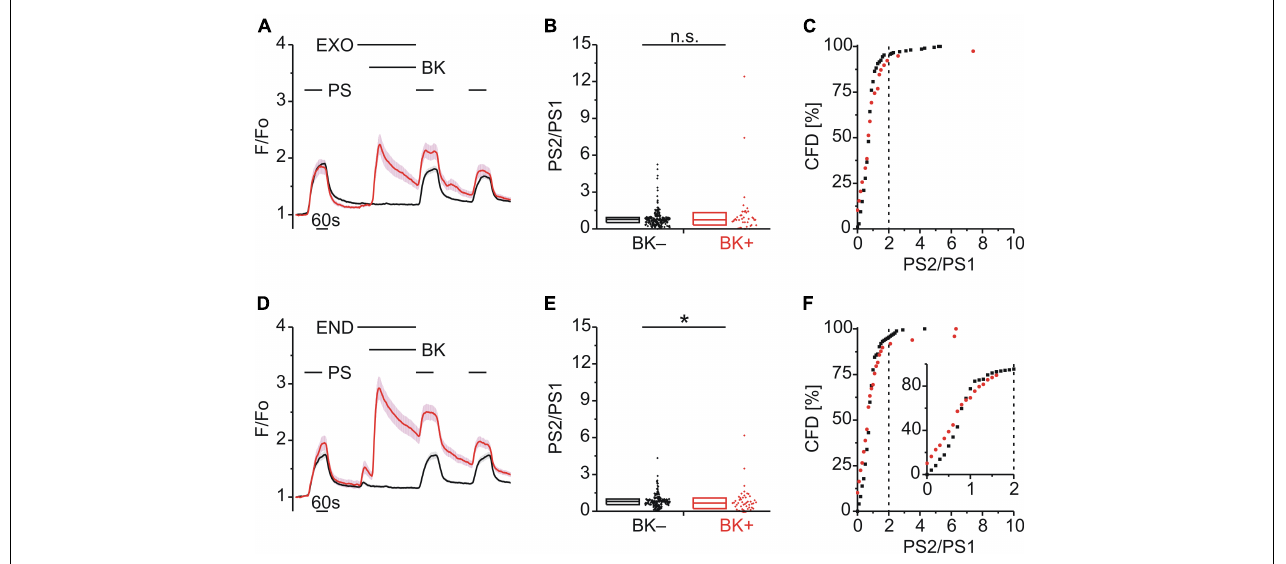
FIGURE 7 | BK-induced TRPM3 sensitization is strongly affected by exocytosis inhibitors. (A–C) Calcium signals from DRG neurons (A) during repeat application of pregnenolone sulfate (PS; 40 µ M) with bradykinin (BK; 0.5 µ M) applied between PS1 and PS2 and in the presence of the exocytosis inhibitor exo1 (EXO; 20 µ M). Cells that showed an increase in calcium to BK are indicated in red (BK+; A–C ; 39 neurons) and those that did not in black (BK–; A–C ; 213 neurons). PS2/PS1 ratios are shown as a simple distribution ( B , boxes indicate quartiles and centerline median) and cumulative frequency distribution ( C ; CFD). Each dot-like symbol in (B,C) represents the ratio value calculated for a single, individual cell. Values derive from six measurements with cells from two mice. (D–F) Calcium signals from DRG neurons (D) during repeat application of PS with BK applied between PS1 and PS2 and in the presence of the exocytosis inhibitor endosidin 2 (END; 10 µ M). BK+ cells are indicated in red ( D–F ; 49 neurons) and BK– cells in black ( D–F ; 174 neurons). PS2/PS1 ratios are shown as a simple distribution (E) and CFD (F) . The inset in (I) illustrates a zoomed in segment of the CFD for ratio values between 0 and 2. Values derive from six measurements with cells from two mice. BK+ and BK– groups (B,E) were compared with Mann-Whitney U -tests. * P < 0.05; n.s., not